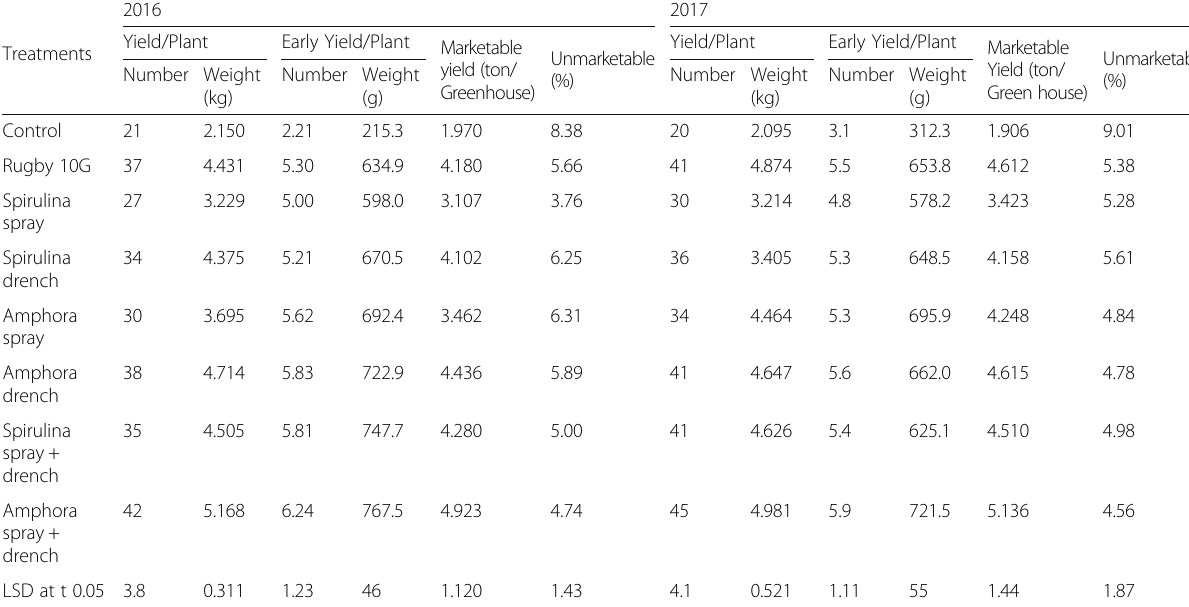
Table 3 Effect of algal treatments of cucumber Hesham hybrid compared with control and Rugby nematicide on early and total, marketable yield and unmarketable yield percentage under infested soil with root-knot nematodes in 2016 and 2017 seasons